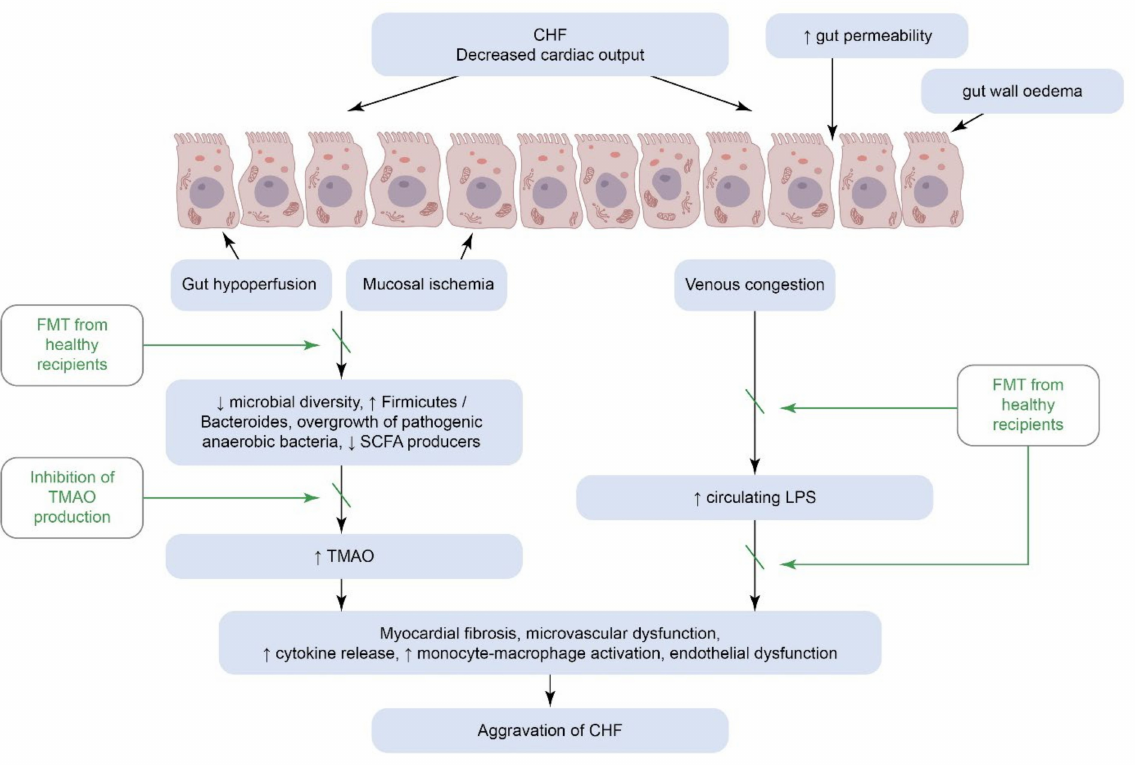
Figure 3. The «gut-heart axis» in the pathogenesis of congestive heart failure. CHF: Congestive Heart Failure, LPS: Lipopolysaccharide, FMT: Fecal Microbiota Transplantation, SCFA: Short Chain Fatty Acids, TMAO:Trimethylamine